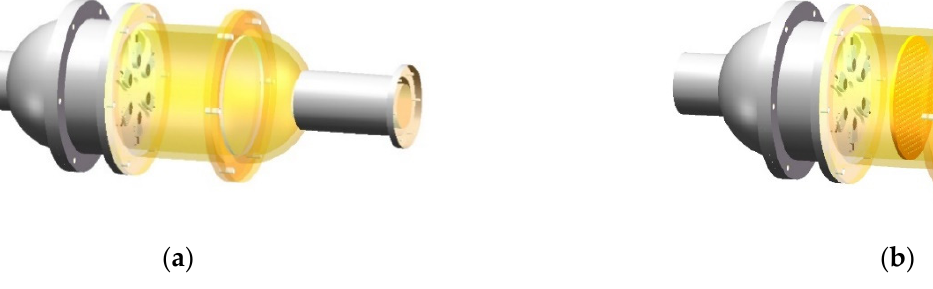
Figure 6. 3D electronic nose model. ( a ) The model without steady flow plates; ( b ) the model with steady flow plates.